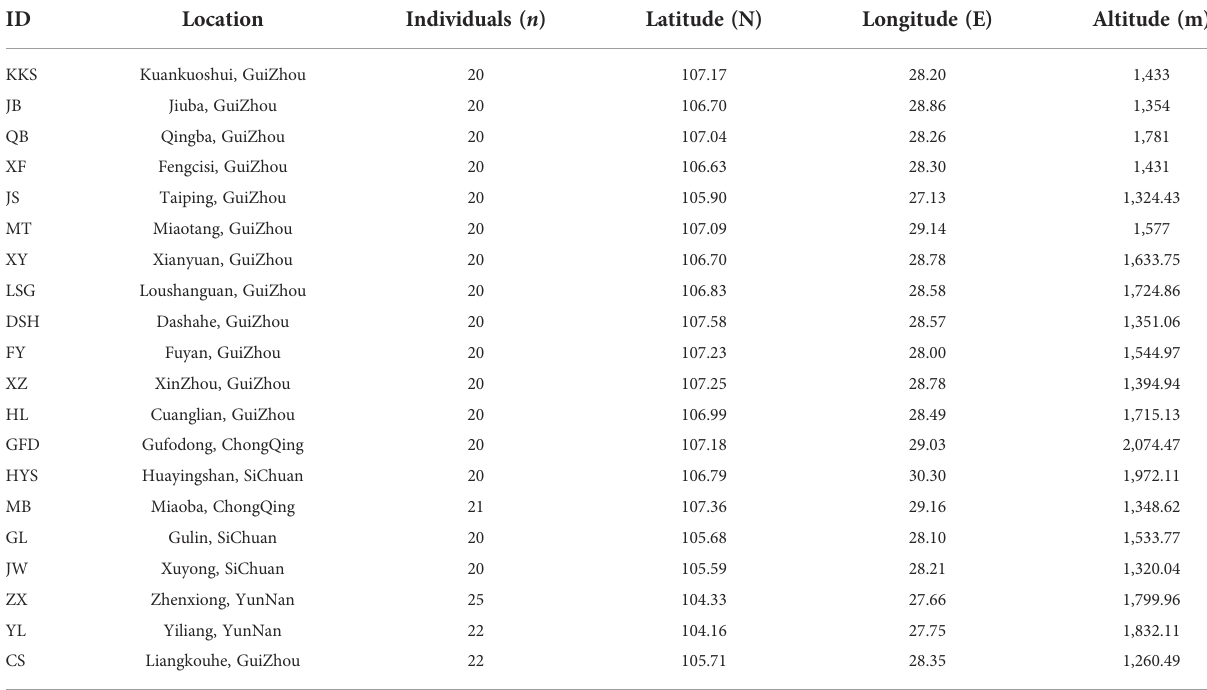
TABLE 1 Sampling information of Ch. utilis